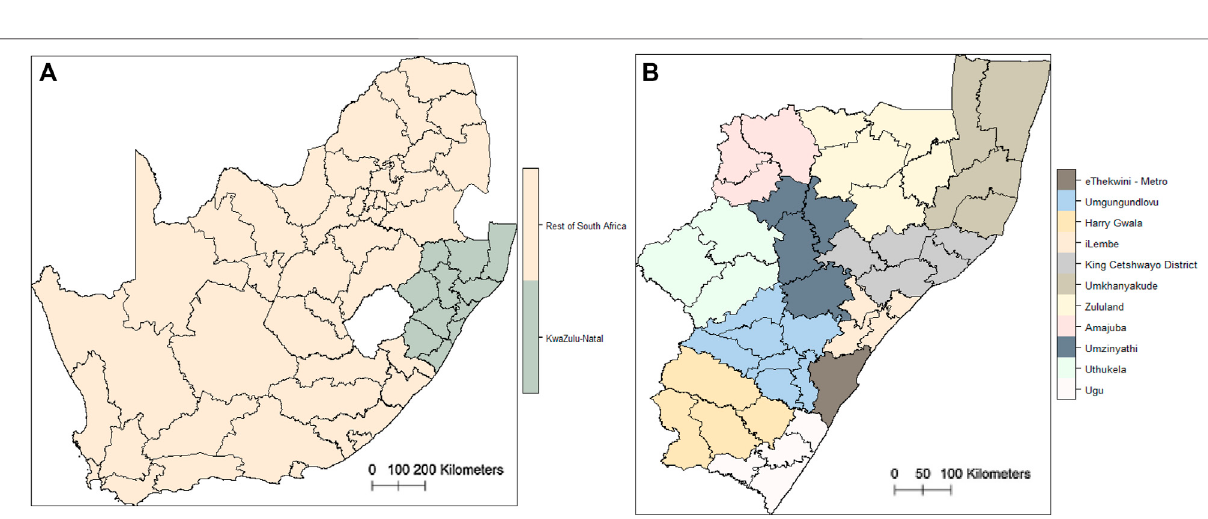
Frontiers in Environmental Science |